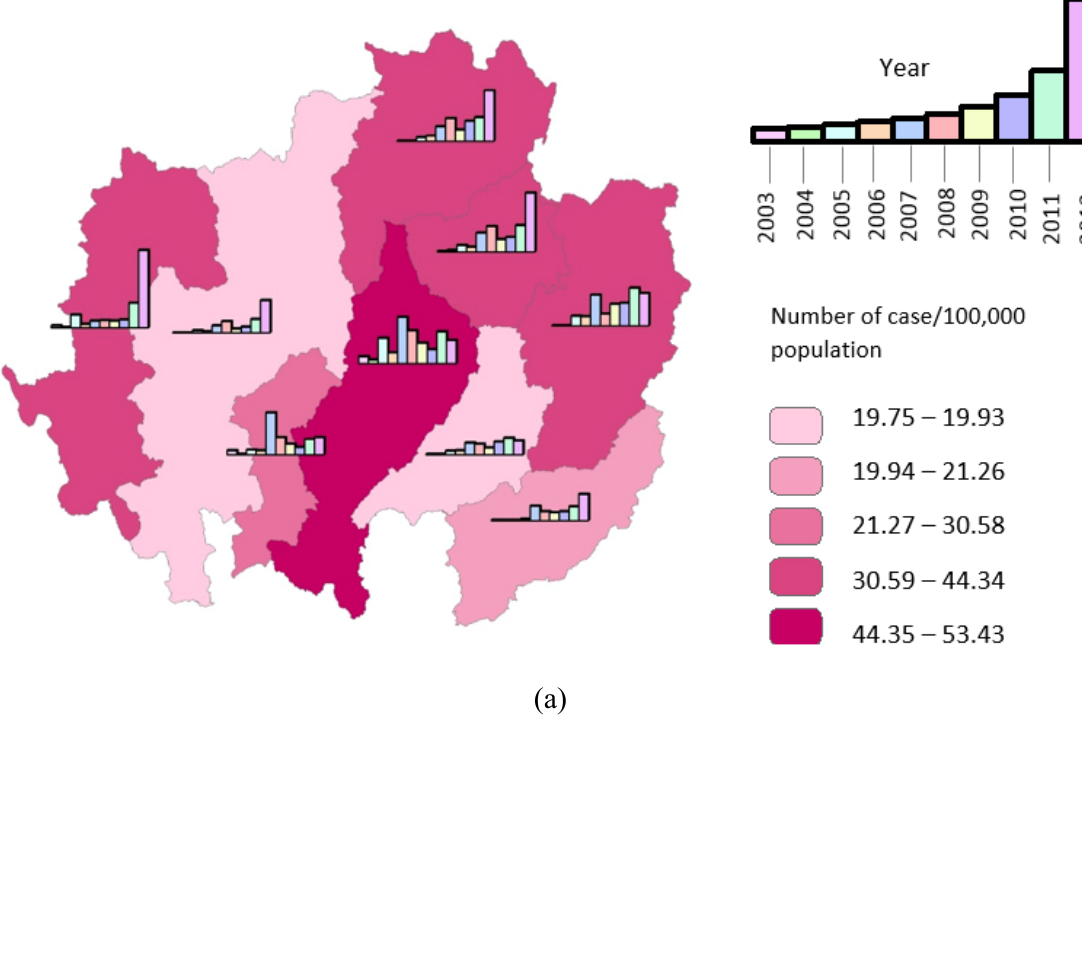
Figure 3. ( a ) Bar charts of the HFMD infection rate for each year by province, shown as average case counts for 2003–2012 per 100,000 inhabitants. ( b ) Yearly Ranking of HFMD cases per capita